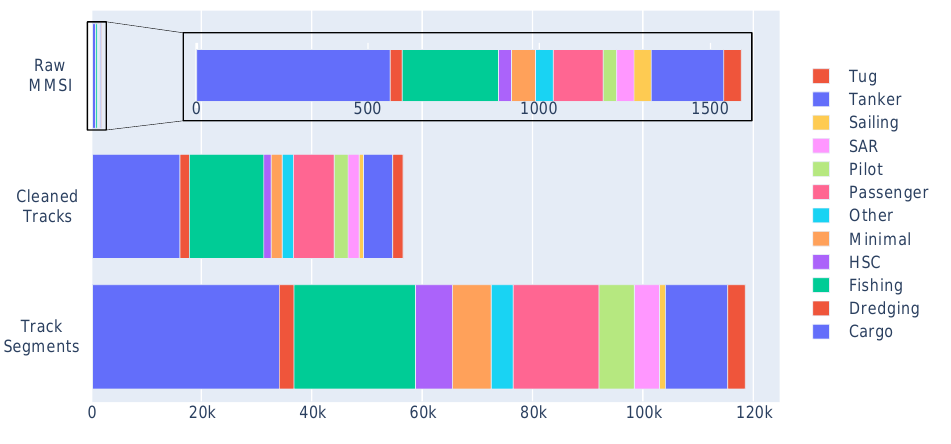
Figure 8. Ship type class distribution.